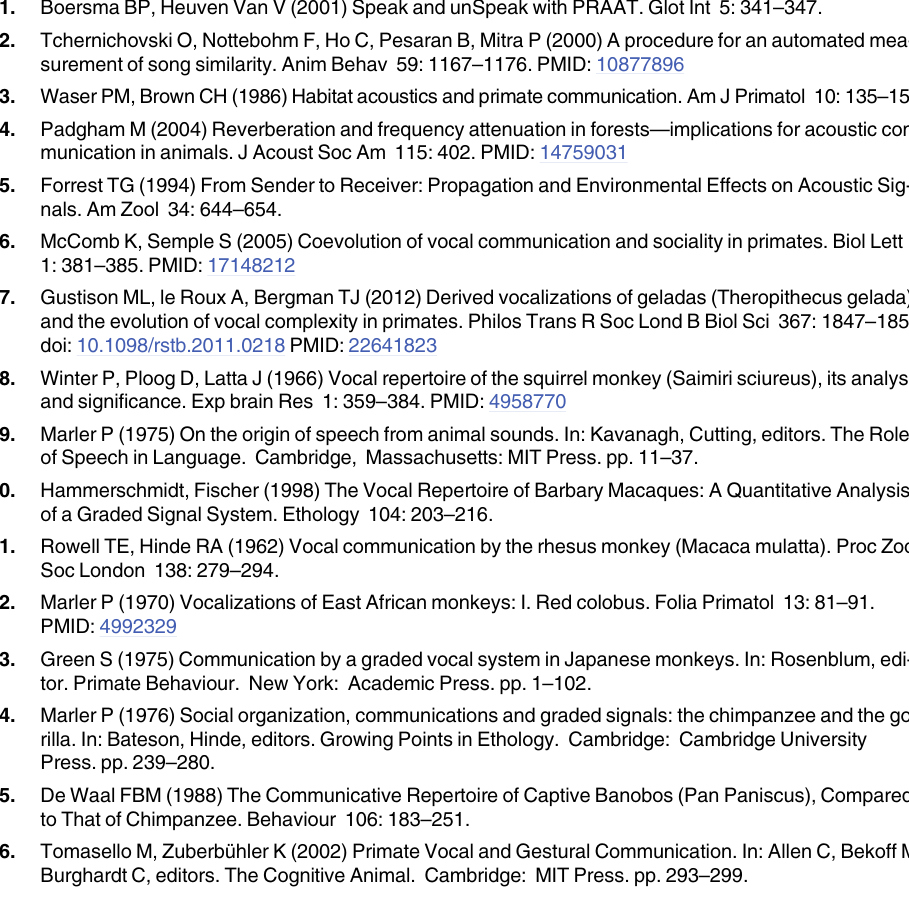
S1 Table. Descriptions of all 118 acoustic features that were used in the analyses. S2 Table. Eigenvalues of first 20 factors. Extraction Method: Principal Component Analysis. S3 Table. Scree Plot Eigenvalues of 118 factors. S4 Table. Rotated Component Matrix. Extraction Method: Principal Component Analysis; Rotation Method: Varimax with Kaiser Normalization; Rotation converged in 21